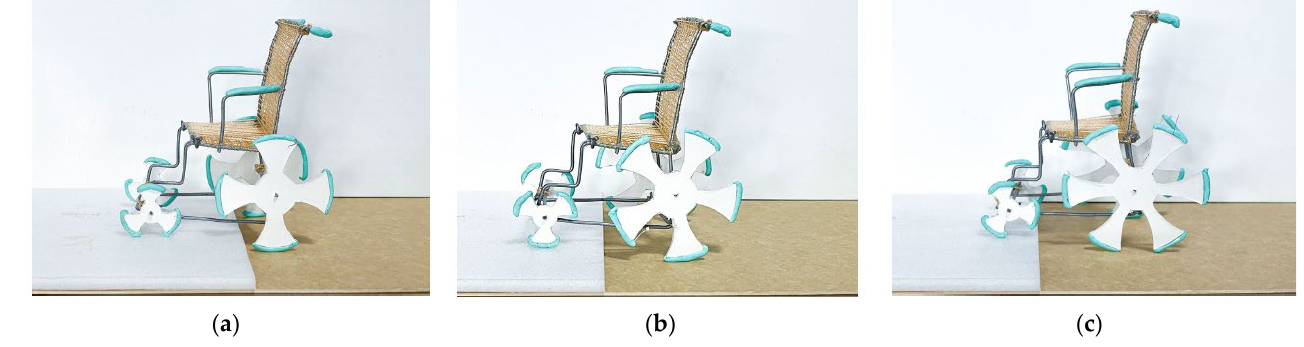
Figure 12. Prototype models with experimental iterations. ( a ) Four-leaf, 20 inches wheel. ( b ) Five-leaf, 22 inches wheel. ( c ) Six-leaf, 24 inches wheel. Photos: [34].